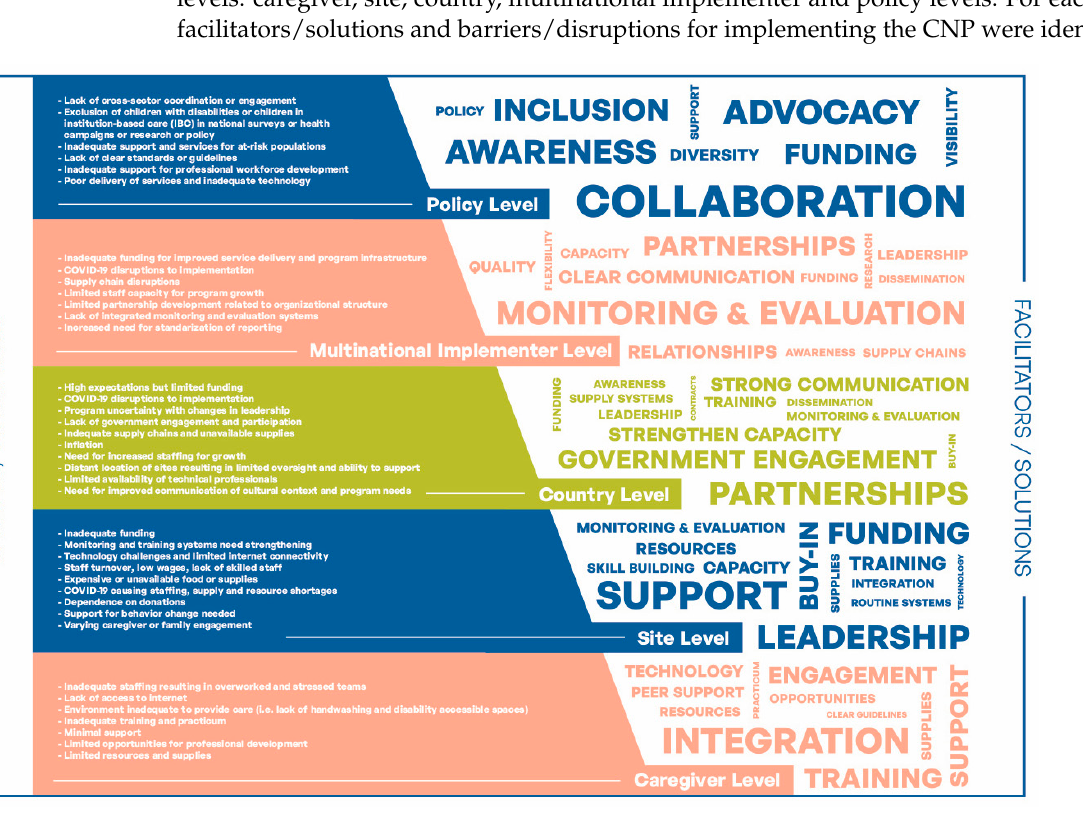
Figure 1. Synthesis of Barriers/Disruptions and Analysis of Facilitators/Solutions to the Implemen- tation of CNP from the KIIs According to Levels of Conceptual Framework.